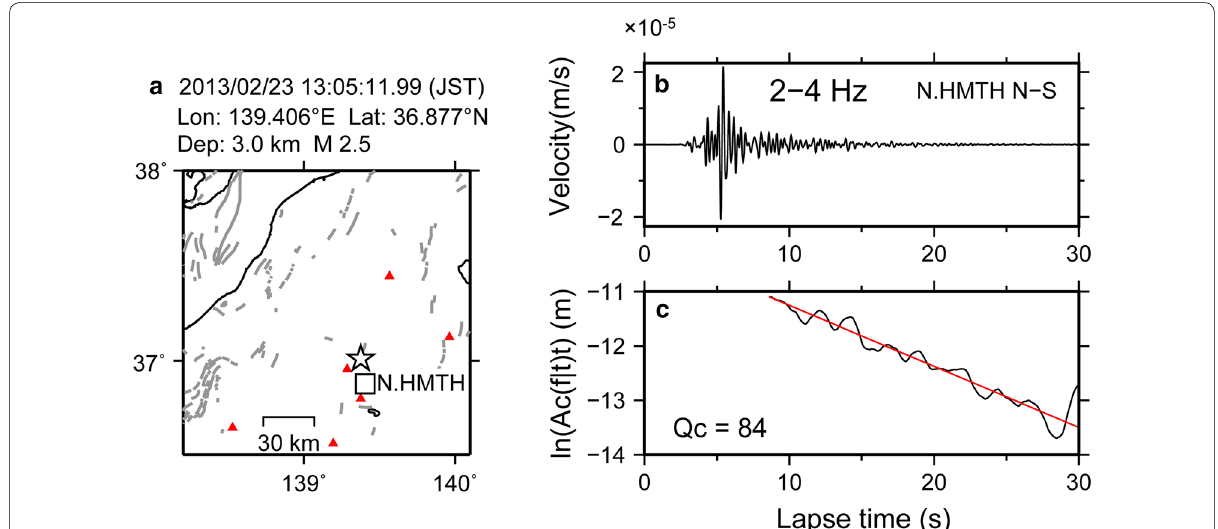
Fig. 2 An example of the estimation of coda Q . a Locations of an epicenter ( star ) and a station ( square ). b Seismic velocity waveforms at the station N.HMTH. c Fitting of Eq. (1) ( red line ) to RMS amplitudes ( black line